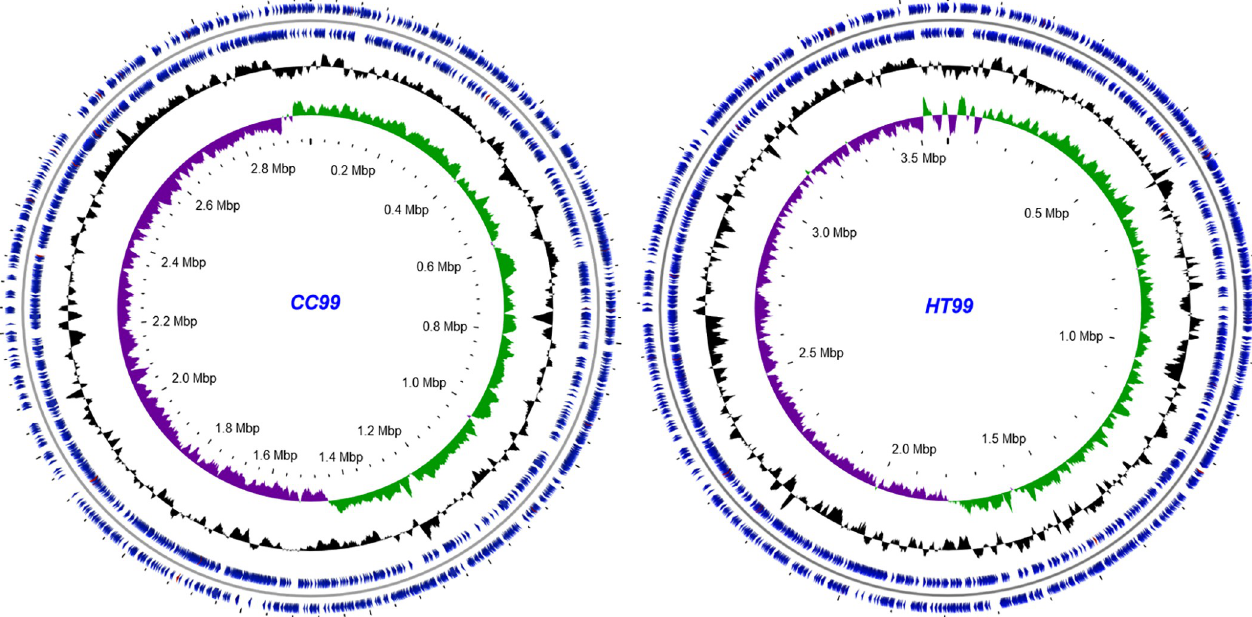
Fig 2. Structural features of “ Ca . B. cookevillensis” (CC99) and “ Ca . B. aquae” (HT99) genomes. Genome tracks show (from inner to outer) the positive (green) and negative (purple) GC skew [(C-G)/(C+G)], G+C content (black) and the coding DNA sequences (blue) located in the reverse and forward and strands. Putative origin of replication is located at the top. CGview (http://wishart.biology.ualberta.ca/cgview/) was used to construct the genome map.